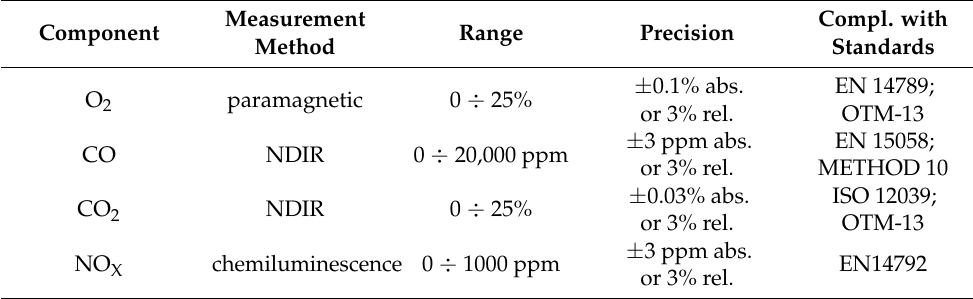
Table 2. Measurement parameters of Madur Photon